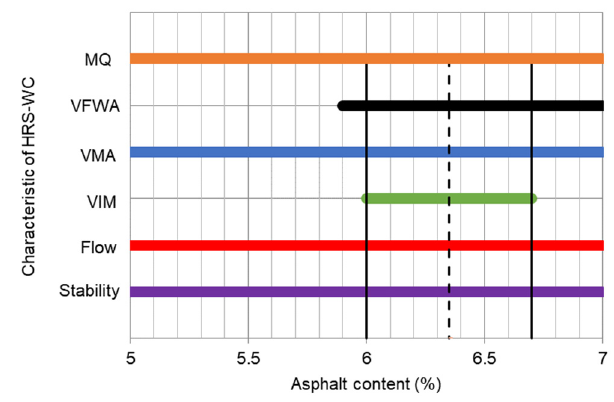
Figure 5. Optimum asphalt content of HRS-WC mixture. Table 4. Marshall properties of AC-WC and HRS-WC asphalt